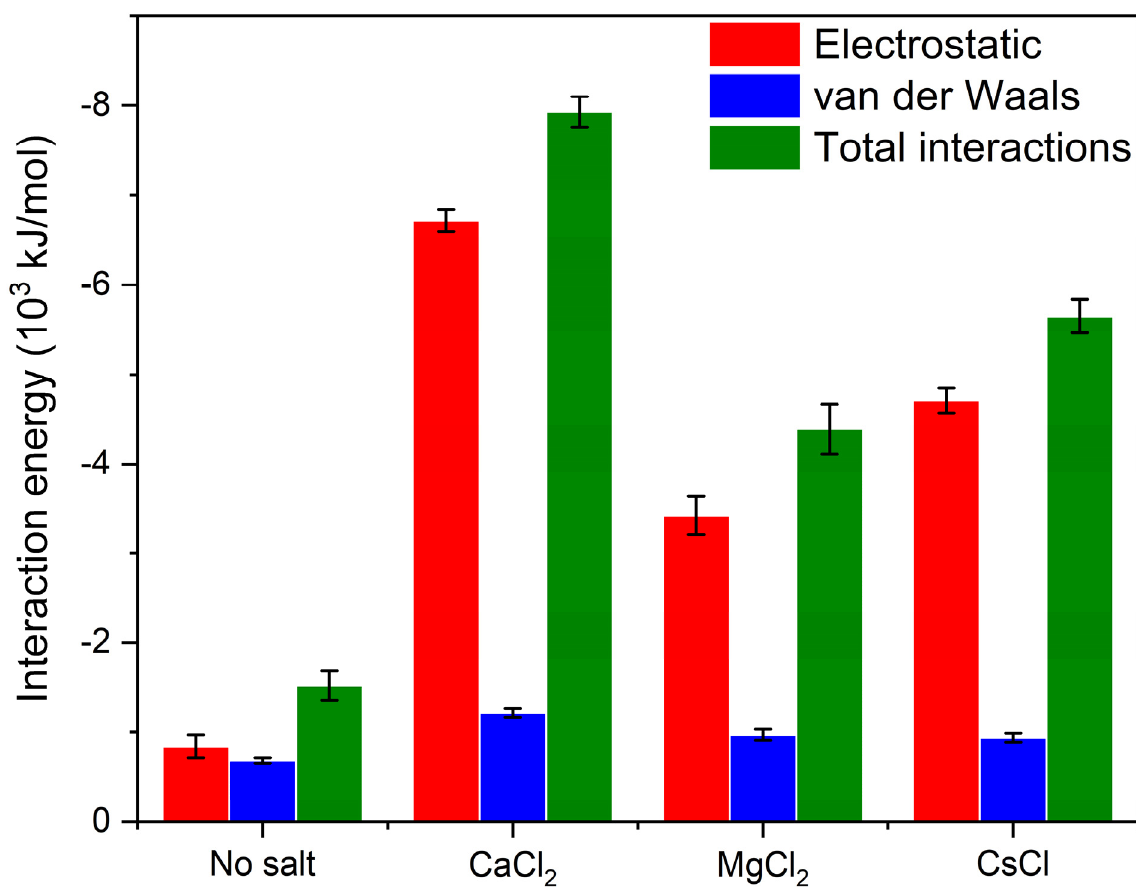
Figure 6. The average intermolecular interaction energies between the laponite disks in the absence and presence of 5 mM of CaCl 2 , MgCl 2 and CsCl. The intermolecular interaction energies are the combinations of van der Waals and electrostatic interactions averaged over the last 5 ns of the simulation time. The error bars of the data represent standard deviations based on simulations performed in triplicate.